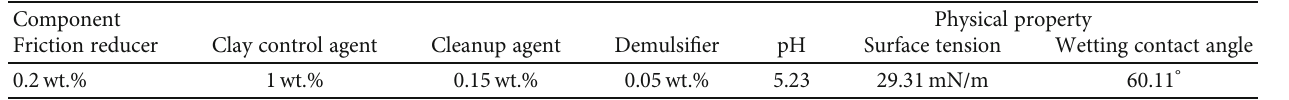
Table 2: Components and physical property of the slick water fracturing fl uid. Component Physical property Friction reducer Clay control agent Cleanup agent Demulsi fi er pH Surface tension Wetting contact angle